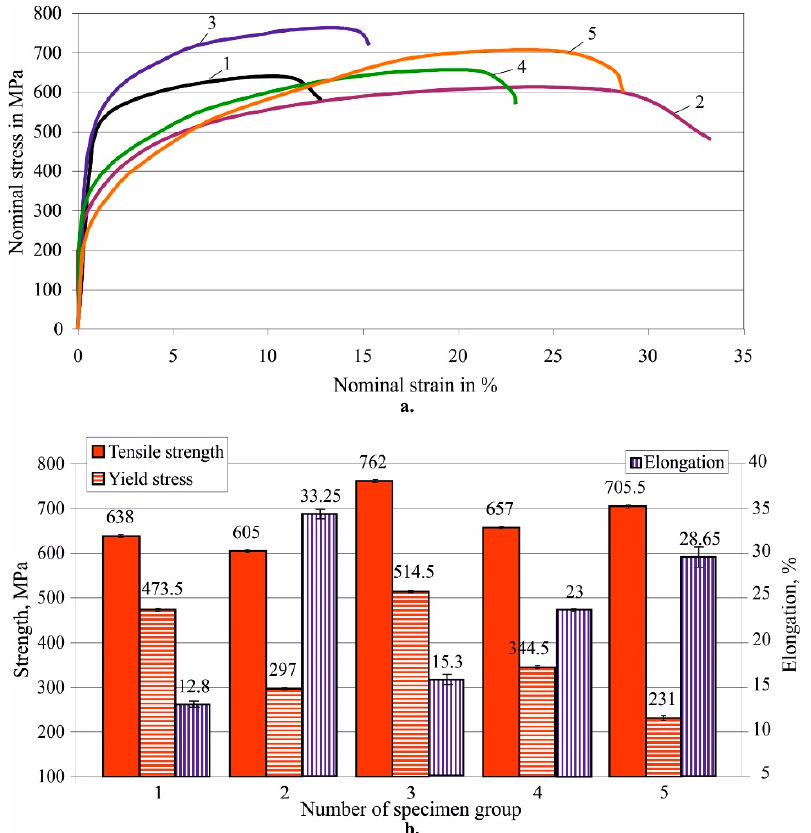
Figure 7. Effect of HT on mechanical characteristics of Cu-10Al-5Fe bronze—tensile strength, yield stress and elongation: ( a ) stress—strain diagrams; ( b ) main mechanical characteristics; 1—as received, 2—annealed, 3—quenched, 4—quenched and tempered at 600 °C, 5—quenched and tempered at 300 °C.